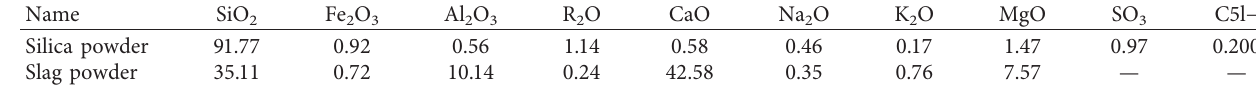
Table 1: Chemical composition of slag powder and silica